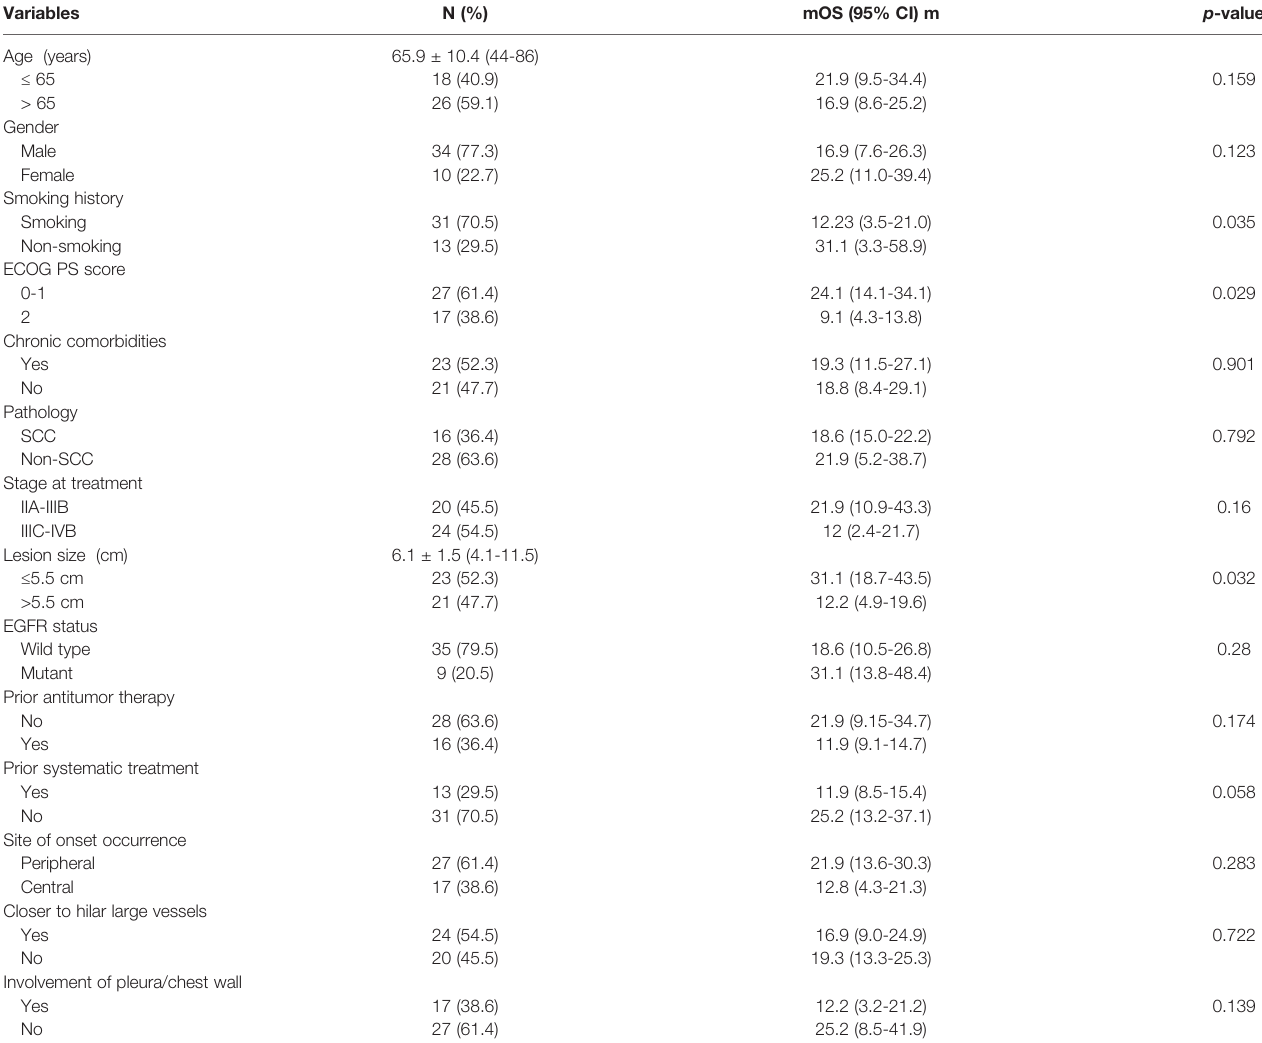
TABLE 1 | Clinical characteristics of 44 patients (44 tumors) and univariate analysis of